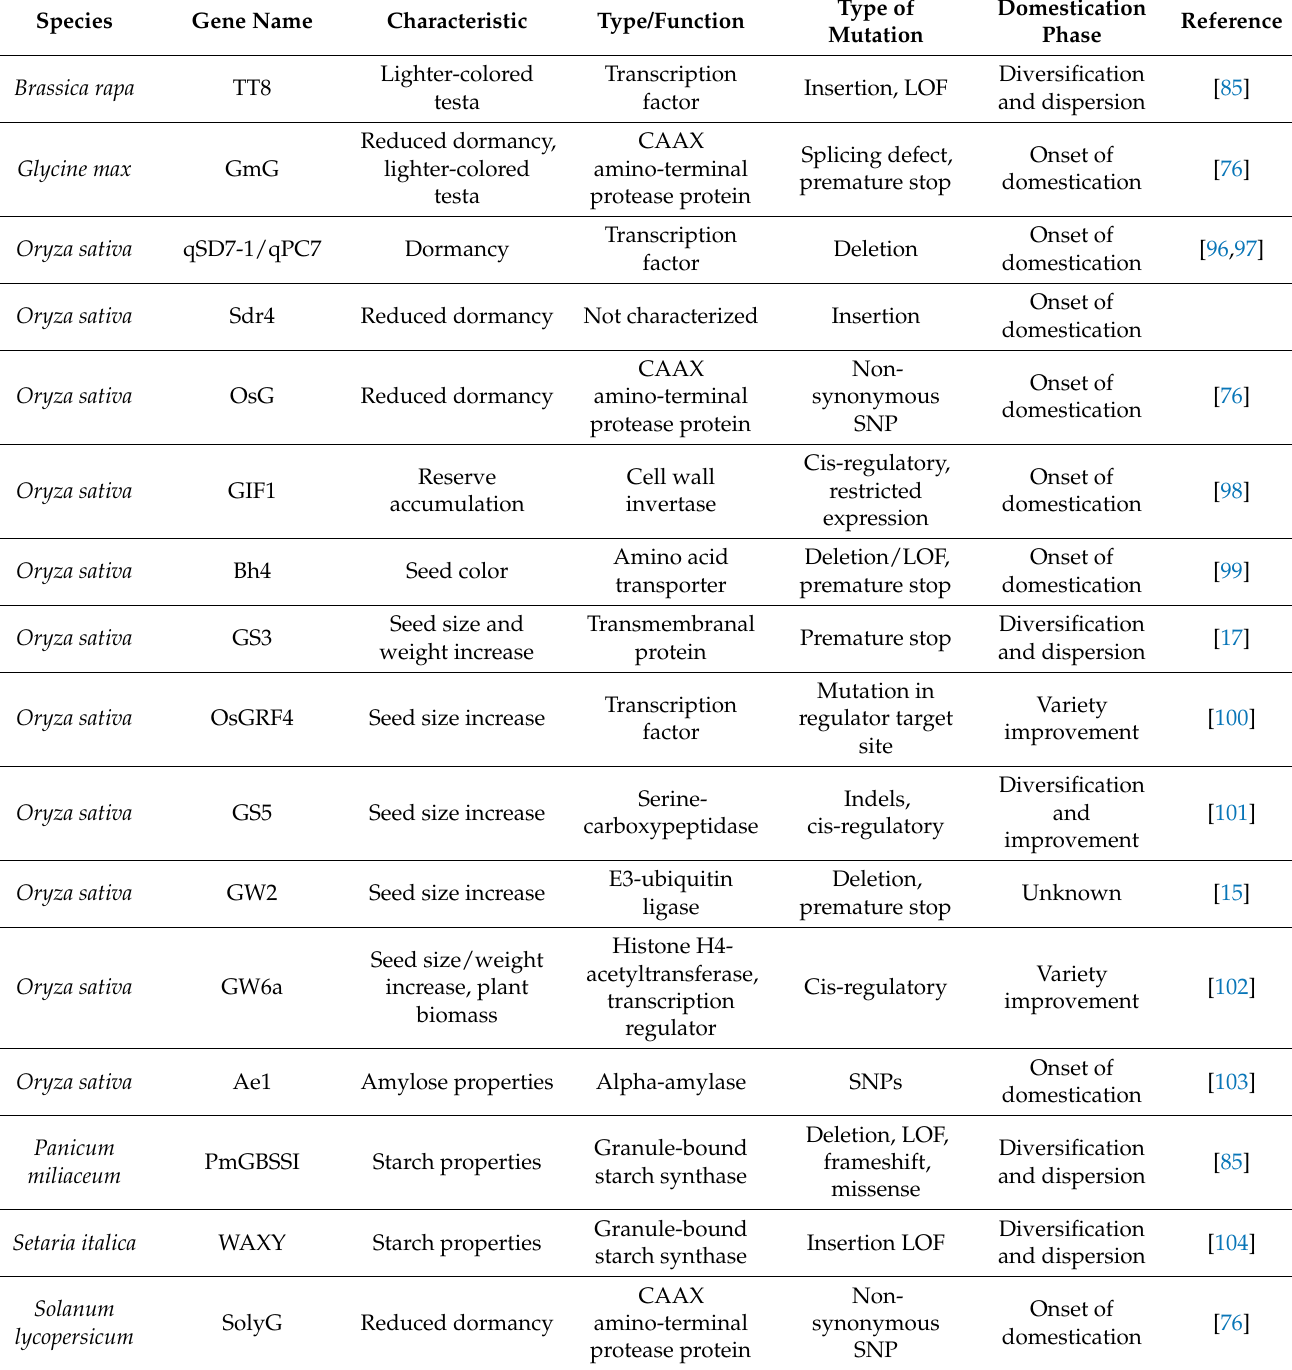
Table 1. Representative genes associated to seed characteristics with evidence of selection during domestication and plant management. Several genes are conserved among taxa, displaying similar functions, which were also characterized in the model plant Arabidopsis through mutant screening. Some domesticated phenotypes are products of complex and lineage/cultivar-specific domestication histories; thus, the same phenotype can arise from multiple mutations. The domestication phase refers to the moment in which such characteristic would have most-likely arisen based on the discussion presented by the authors and on the four-phase model proposed by Meyer and Purugganan [85]: phase 1 onset of domestication; phase 2 diversification; phase 3 dispersion from original distribution; and phase 4 variety